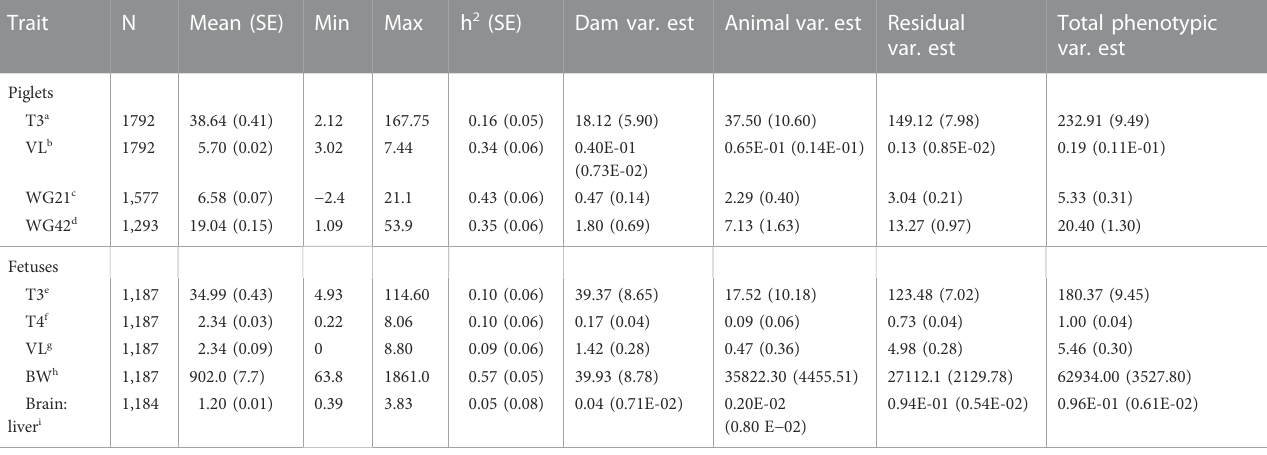
TABLE 1 Descriptive statistics, heritability, and variance (dam, animal, residual, and total phenotypic) estimates of piglet and fetal traits. Trait N Dam var. est Animal var. est Residual